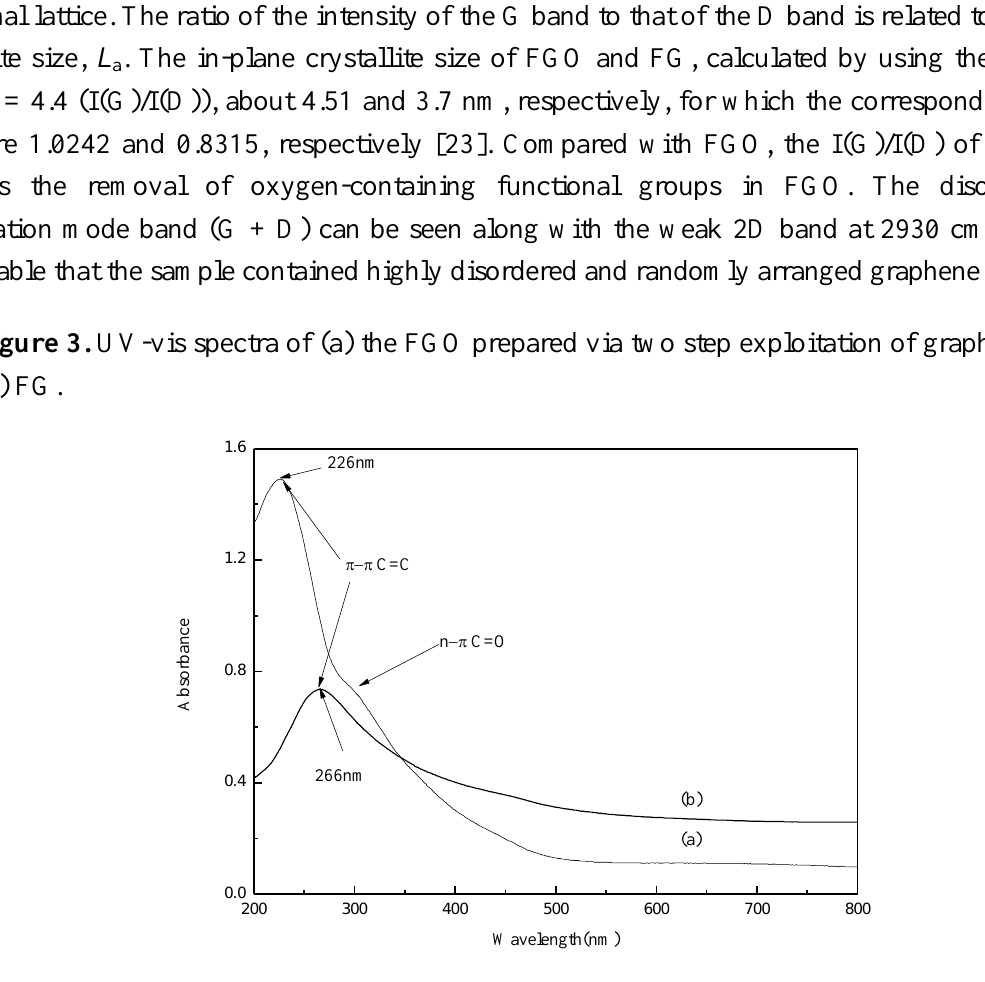
Figure 4. Raman spectra of the samples: (a) FGO; (b)